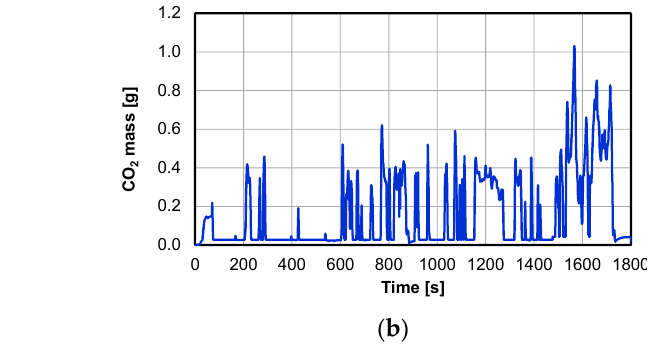
Figure 18. The CO mass versus time for: ( a ) plug-in; ( b ) HEV.